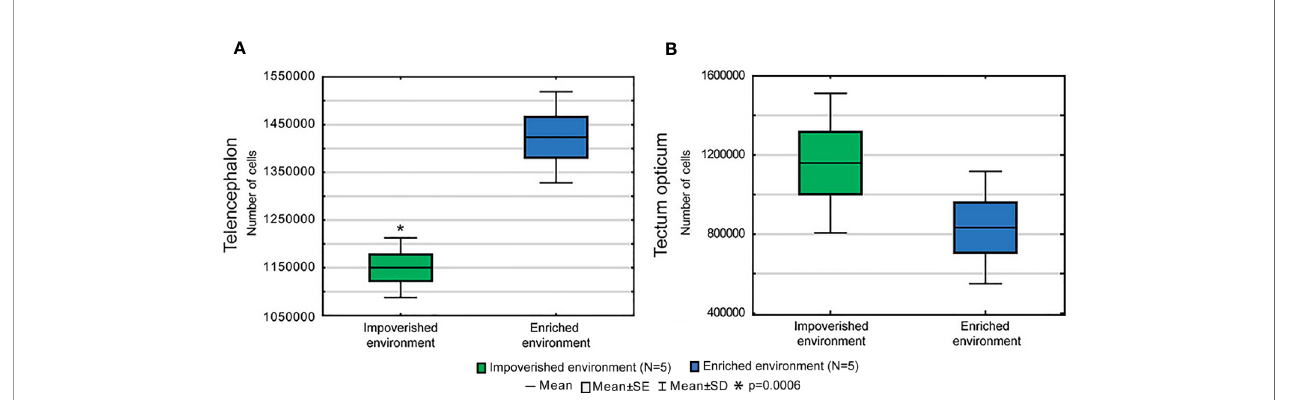
FIGURE 6 | Total number of cells of the telencephalon (A) and tectum opticum (B) from individuals raised in enriched (EE) or in impoverished (IE) aquaria. The average total number of telencephalic cells was greater in EE than in IE animals. Non-signi fi cant differences were found in the tectum